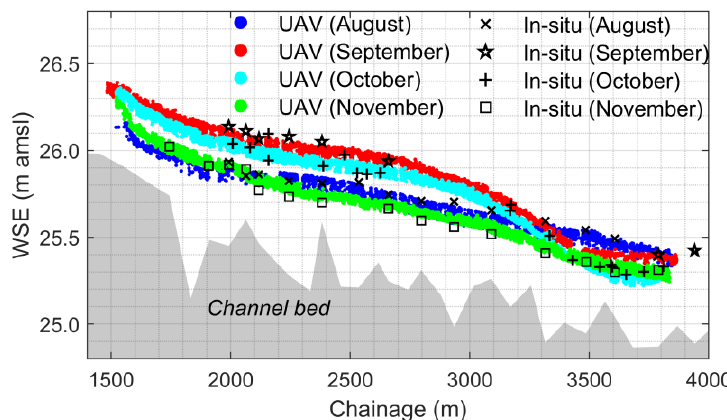
Figure 5. Longitudinal profile plots of WSE derived from four unmanned aerial vehicle (UAV) campaigns against in-situ measurements. The shaded area indicates the channel bed, which is represented by the deepest point in each cross-section.